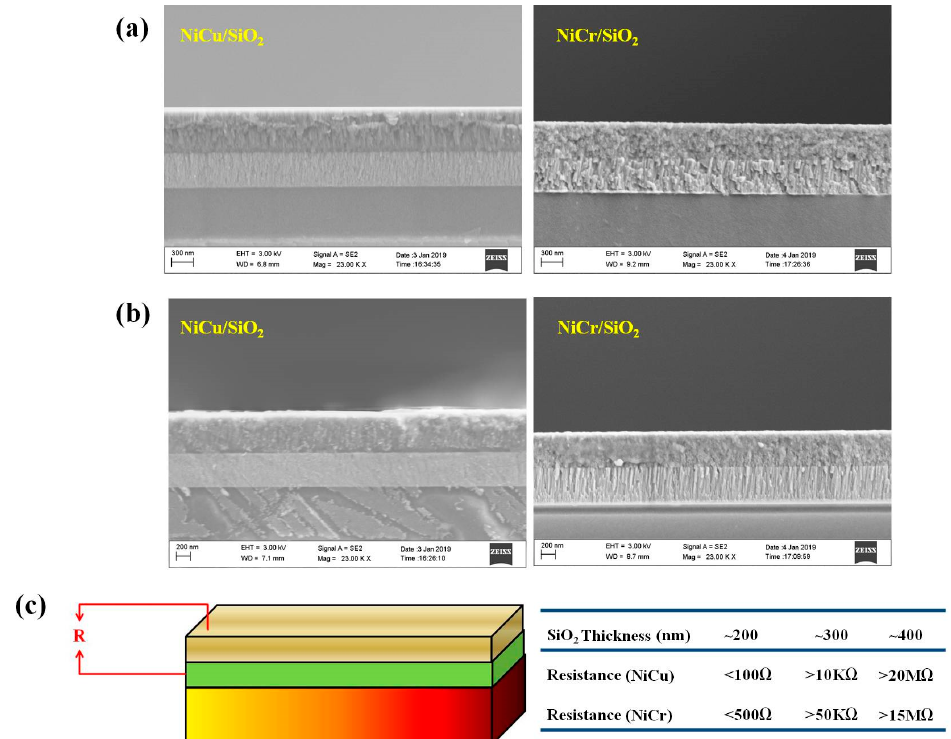
Figure 2. ( a ) The cross-section images of NiCu/SiO 2 and NiCr/SiO 2 thin films; ( b ) The cross-section images of NiCu/SiO 2 and NiCr/SiO 2 thin films after heating; and ( c ) The resistance between the TE thin films and SiO 2.